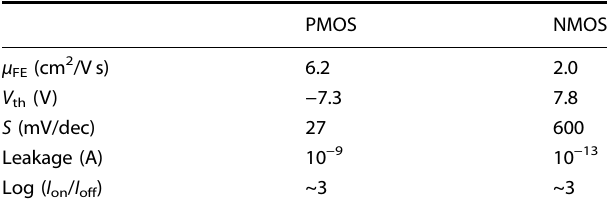
Table 1. TFT properties of silicon ink-based PMOS and NMOS TFT fabricated on top of a paper